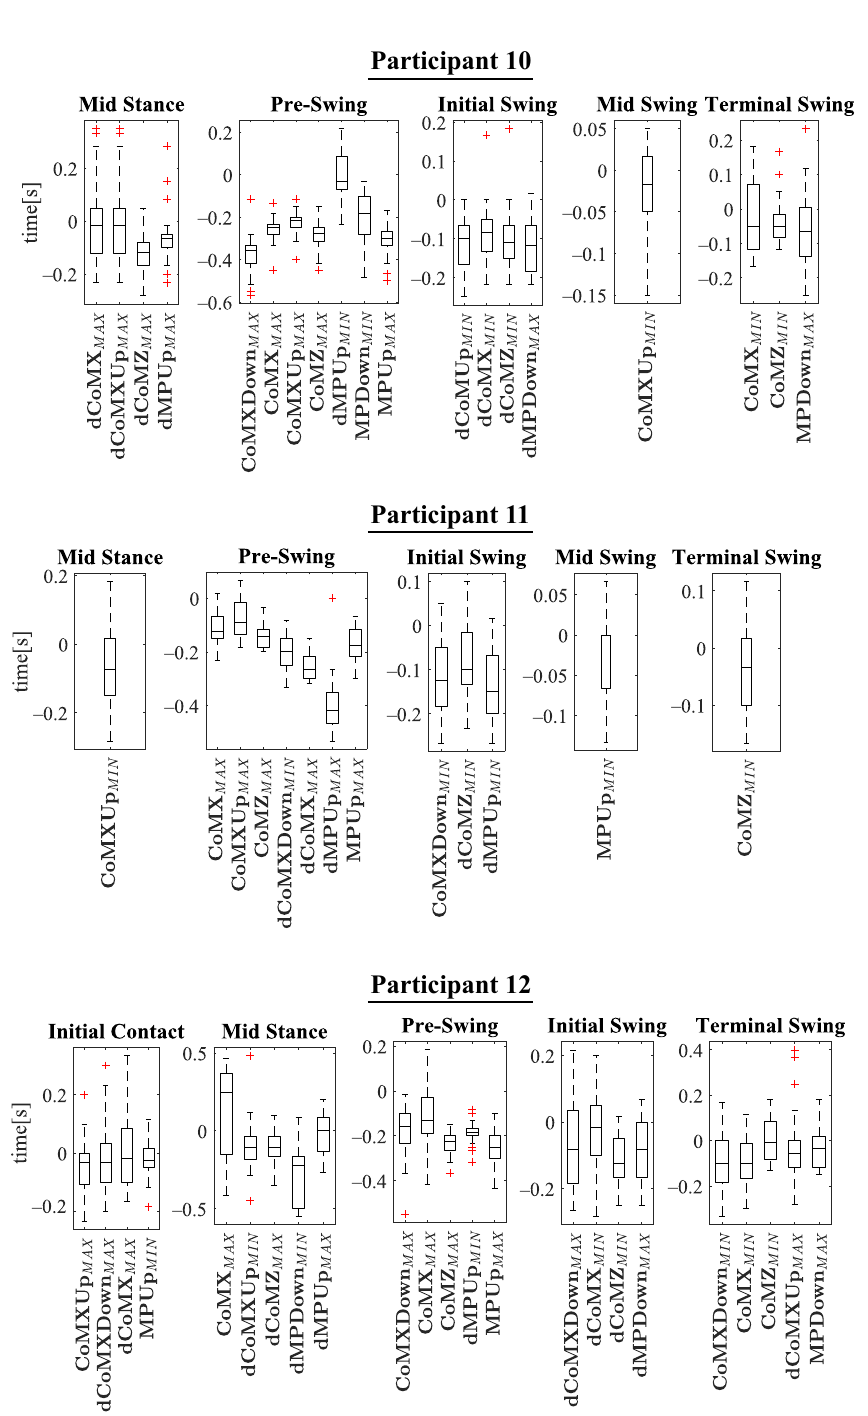
Figure 14. Experimental results for P10–P12. In the y -axis, 0 s is the time corresponding to the phase beginning. Negative time values mean that the event appears before the phase, and positive values that the event occurs after the phase has